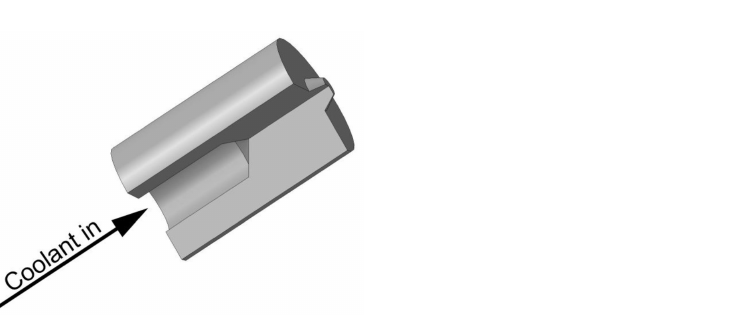
Figure 1. Schemes of friction stir welding titanium alloys with argon gas blanket of the welding joint and liquid tool cooling. Blue and green arrows show the coolant fluid and gas flow directions, respectively. Red arrows show the tool rotation and transverse motion and axial plunging force. Directions.